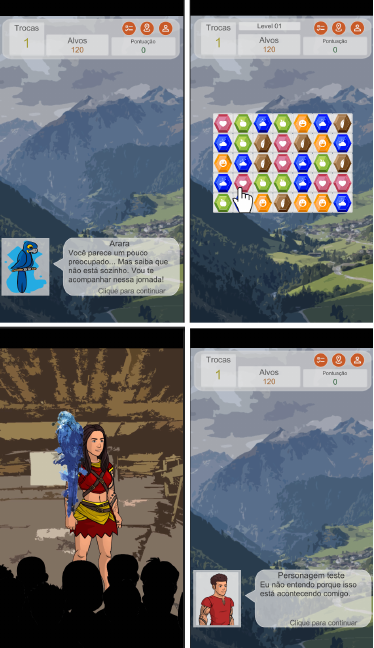
Figure 12. Some game screenshots, representing the tile-matching, dialogs and narrative video.